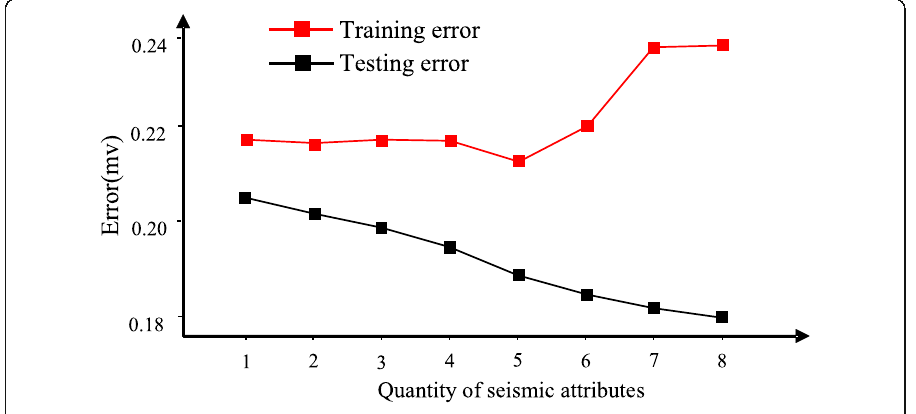
Fig. 4 Quantity of seismic attributes vs .